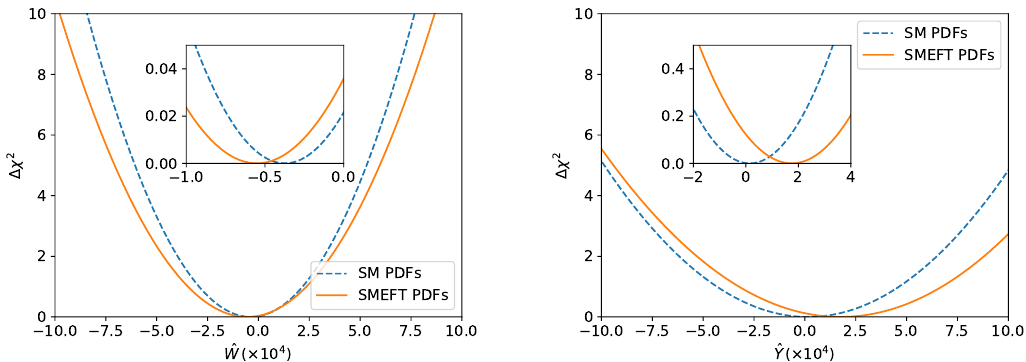
Figure 5 . Comparison between the results of the parabolic fits to ∆ χ 2 , eq. (4.2), for the ˆ W (left) and ˆ Y (right panel) parameters for either the SMEFT PDFs ( χ 2 , already displayed in figure 4) eftp or the SM PDFs (hence with χ 2 ). The insets zoom on the region close to ∆ χ 2 ’ 0 smp